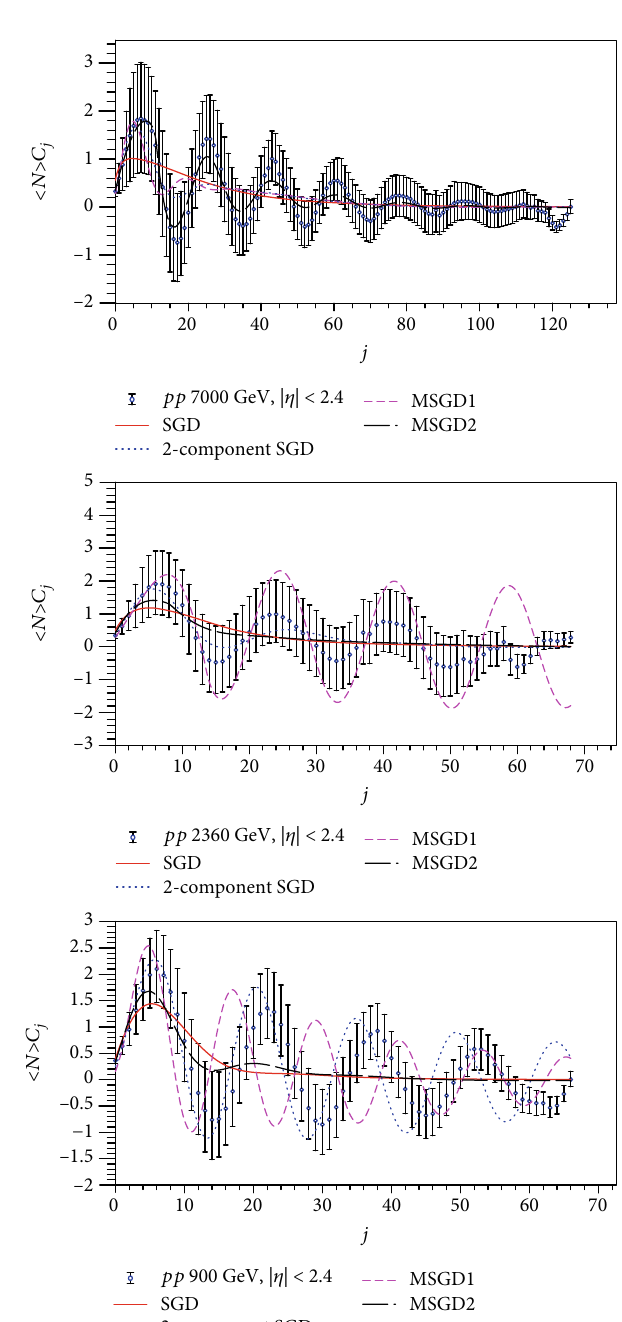
Figure 9. It may be observed that none of the fi ts consistently follow the p (cid:1) p data trends. This is also seen for other η win- dows. To avoid too many similar fi gures, we present only the representative fi gures.